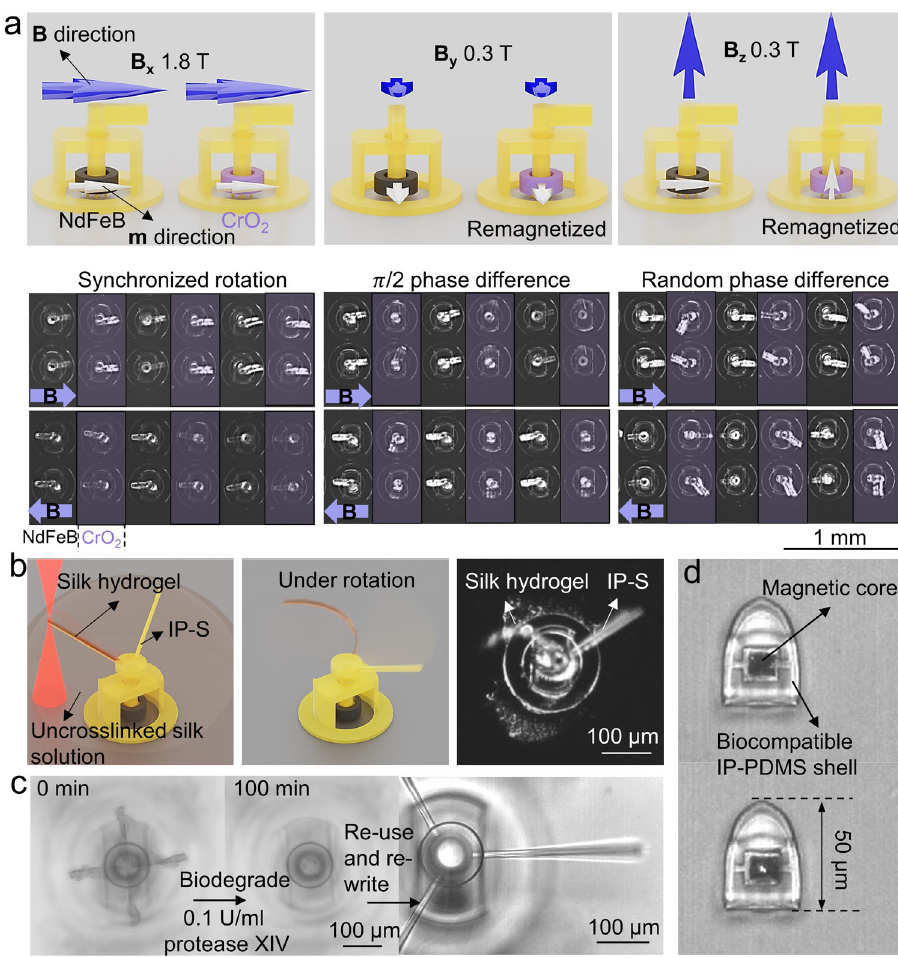
Fig. 3 Reprograming, recon fi guring, and passivating the microdevices enabled by DLW and micro-molding with multiple material types. a Reprogramming the m directions (white arrows) of the micro-rotors by applying magnetic fi eld B (blue arrows). The video (Supplementary Movie 4) frames at the bottom correspond to each reprogramming scenario above. The micro-rotors are immersed in water with a 15 mT in-plane rotating magnetic fi eld. The magnetic rings for color shaded rotors are composed of CrO 2 and the other ones are composed of NdFeB. b Schematics showing the DLW process of silk hydrogel and the bending motion under rotation. The video (Supplementary Movie 5) frame shows the spinning motion of the micro-rotor under a 15 mT 0.8 Hz rotating magnetic fi eld in the water. c Recon fi guring the geometry by degrading the printed silk “ windmill ” structure in protease XIV solution at room temperature, then rewriting three beams on the same micro-rotor base. d Micro-capsules with fully encapsulated NdFeB-silicone rubber composite core with DLW biocompatible IP-PDMS